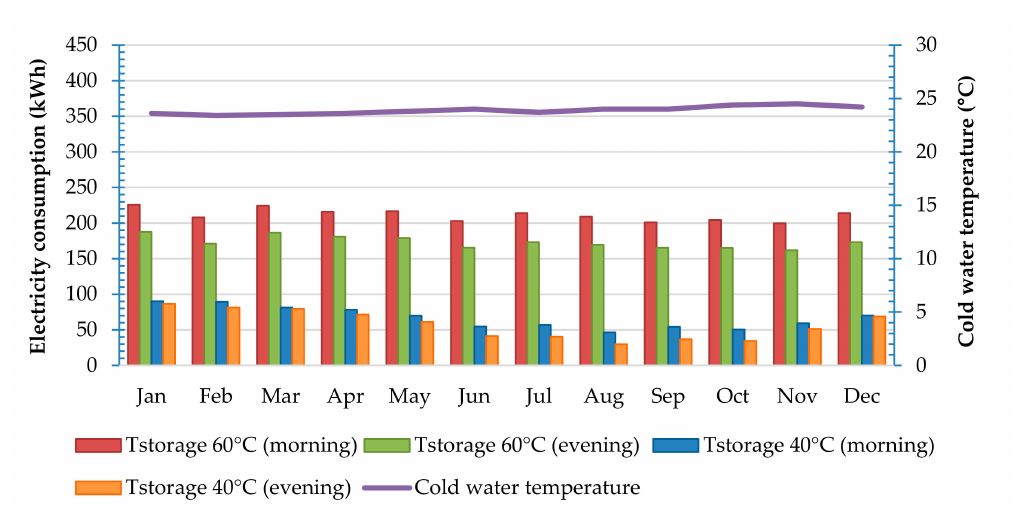
Figure 10. Electricity consumption using solar heating systems with a boiler in Bel é m.